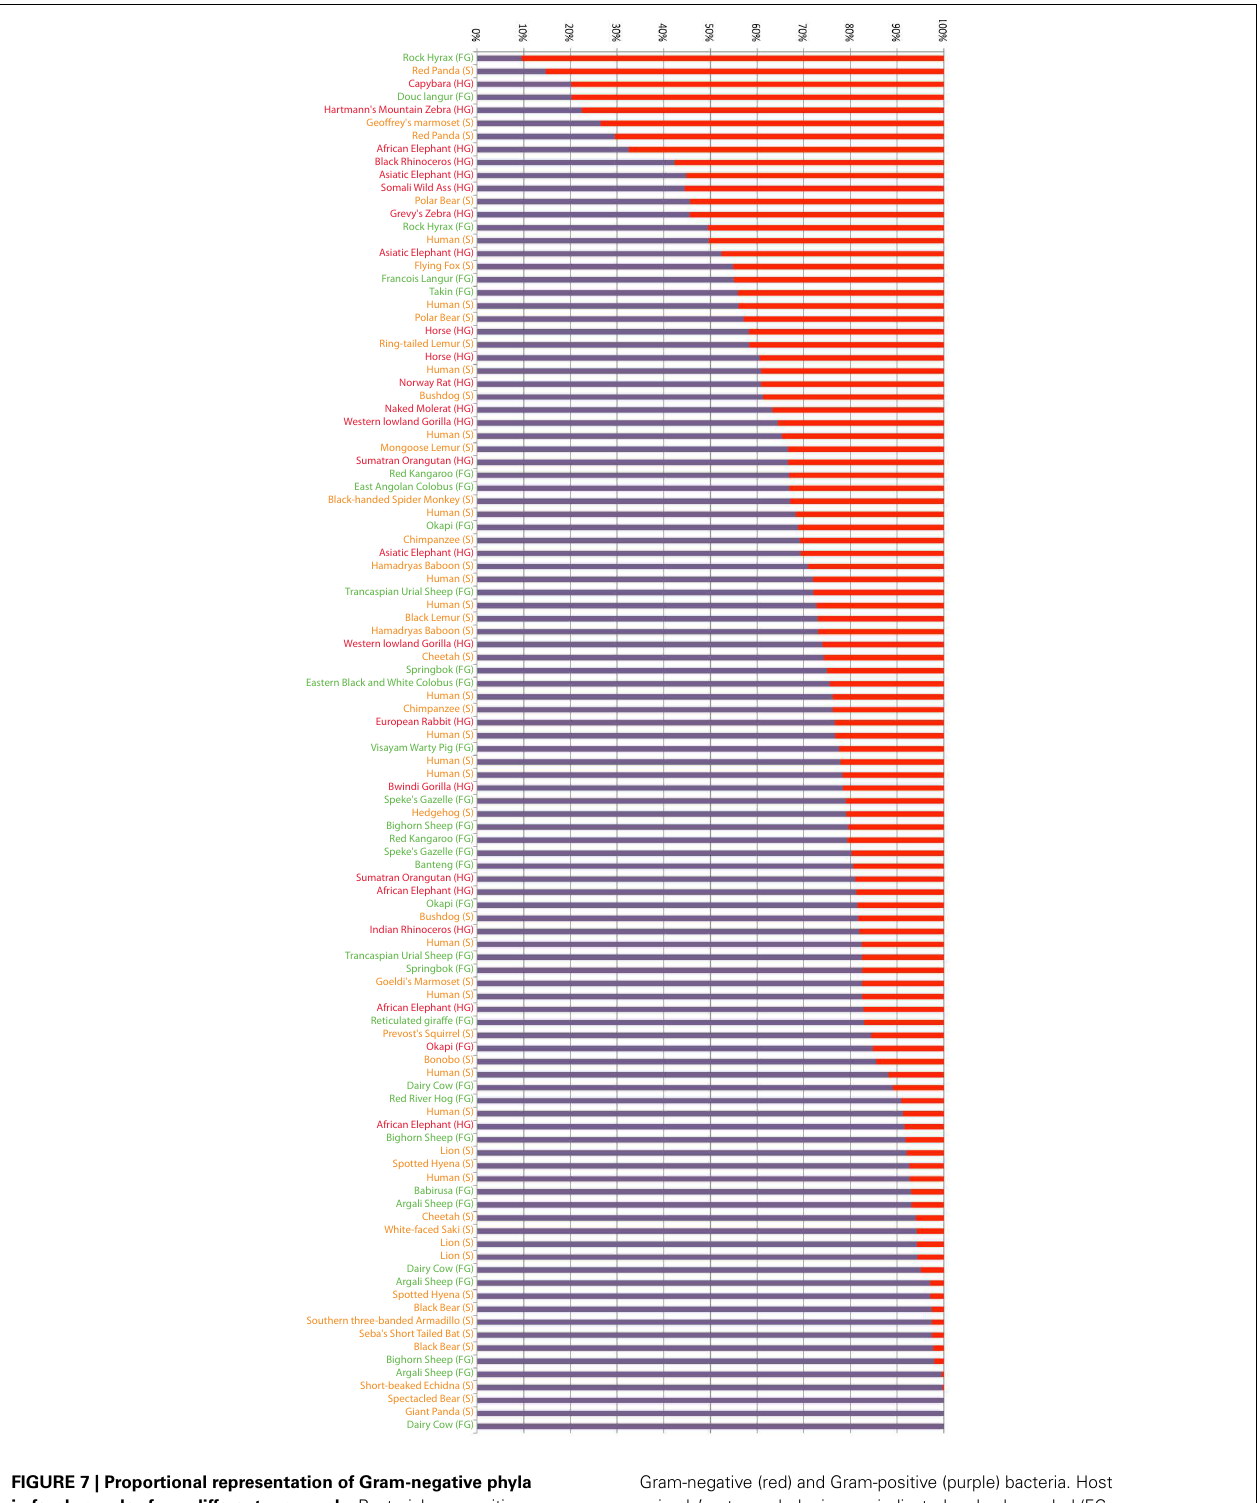
Gram-negative (red) and Gram-positive (purple) bacteria. Host animals’ gut morphologies are indicated and color coded (FG, foregut fermenter in green; S, simple in yellow; HG, hindgut fermenter in